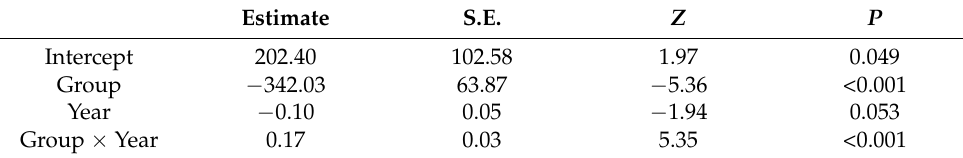
Table 3. Results of logistic regression with Poisson function of error